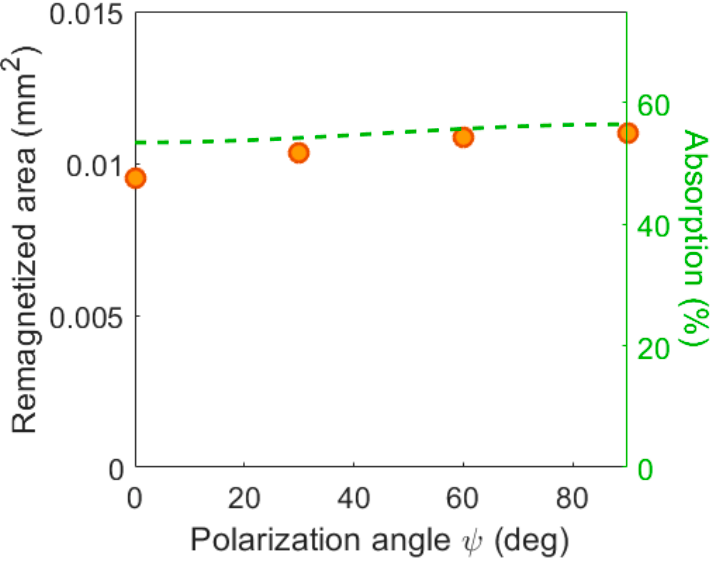
Figure A2. Magnetization switching via femtosecond pulses of different polarization. Experimental measurements of the remagnetized area (left axis) and simulated light absorption (right axis) dependence on the polarization of the femtosecond pulse ψ .